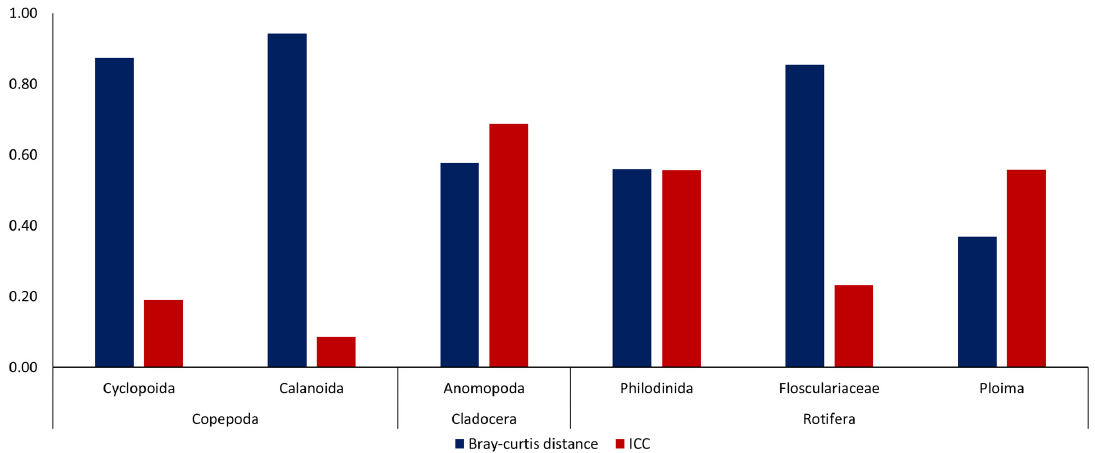
Figure 4. The Bray–Curtis distance and intracross correlation values of the order of zooplankton between the sampling methods.